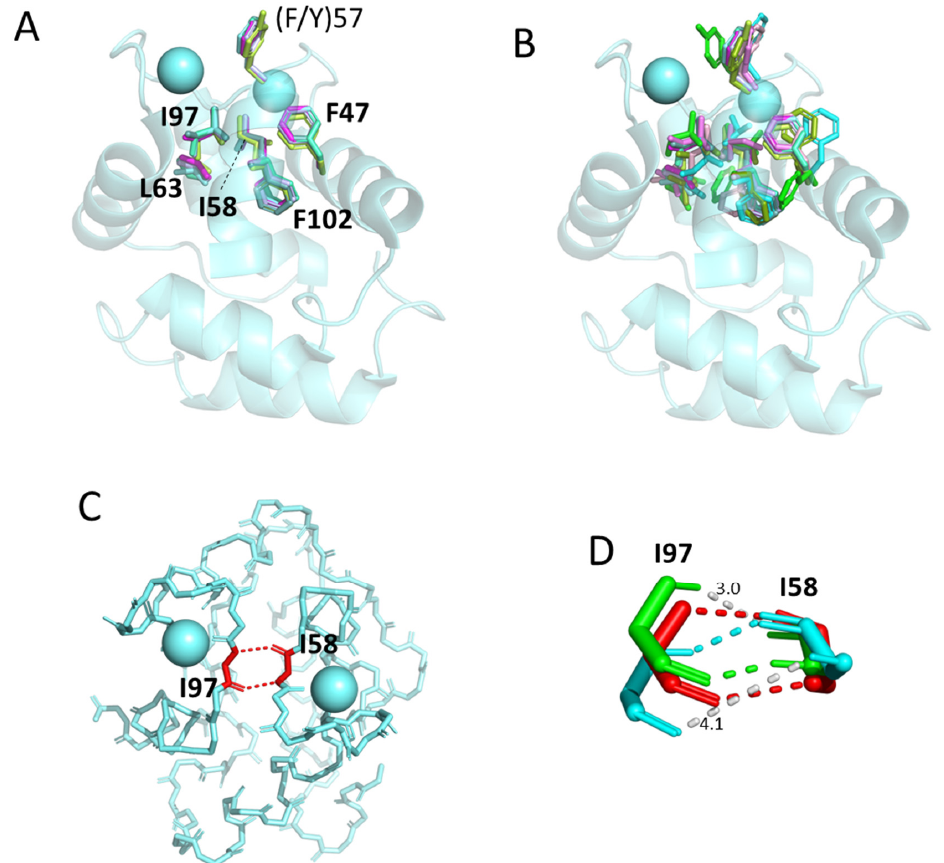
Figure 6. The conserved core residues in the proximity of the Ca 2+ binding sites show a well ‐ conserved orientation among parvalbumin structures determined by X ‐ ray crystallography but less so among structures determined by NMR. ( A ) Superimposition of X ‐ ray crystallography structures of ‐ parval ‐ bumin (magenta, spotless smooth ‐ hound shark SPV ‐ I [5ZGM]), oncomodulin (limon, rat oncomodulin [1OMD]), and other parvalbumins (soft purple, chicken ATH [3FS7]; green cyan, pike pvalb3 [1PVB]; aquamarine, common carp pvalb4 [Chr.B3] [4CPV]; light teal, spotless smooth ‐ hound shark SPV ‐ II [5ZH6]). ( B ) As ( A ), but with additional superimposition of structures determined by solution NMR of ‐ parvalbumin (light pink, human ‐ parvalbumin [1RK9]; pink, pike pvalb7 [2PAS]), oncomodulin (green, human oncomodulin [1TTX]; splitpea green, chicken oncomodulin [CPV3] [2KYF]), and other parvalbumin (cyan, Atlantic cod pvalb2 [2MBX]). ( C ) The beta ‐ strand type connection between